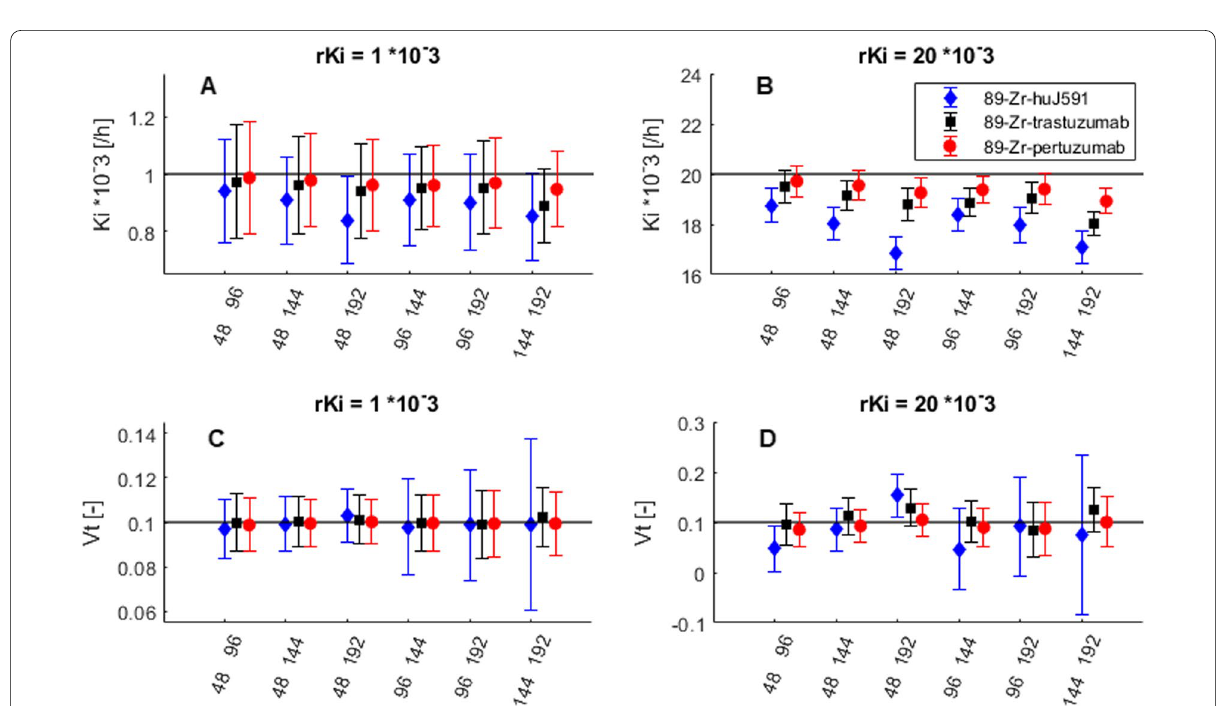
Fig. 5 Absolute K i ( A and B ) and V T ( C and D ) values per time point combination for 89 Zr‑huJ591, 89 Zr‑trastuzumab and 89 Zr‑pertuzumab input functions, with rK i 1 and 20 10 − 3 [h − 1 ], rV T 0.1 and time activity curves with 5% noise. All time point combinations on the x‑axis also included = · = 24 h post‑injection.